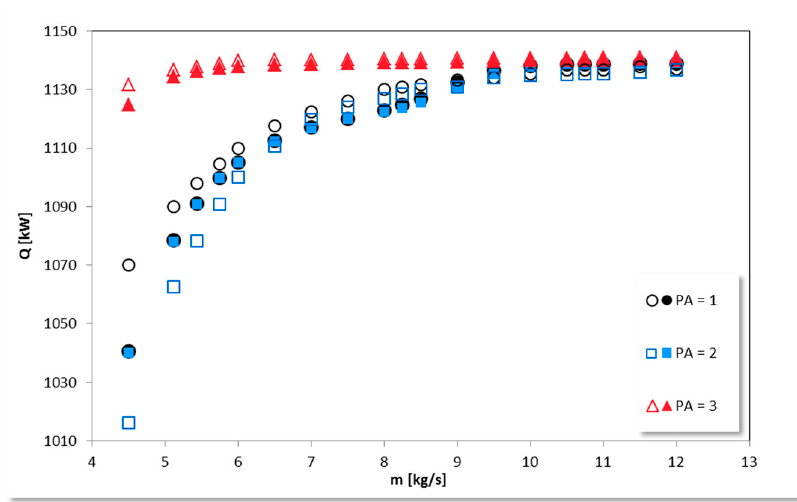
Figure 6. The dependence of the total heat transfer rate Q desired (blank symbols) and predicted (filled symbols) with the refrigerant mass flow rate, for different tube pass arrangements PA (KT = 4, n = 5).